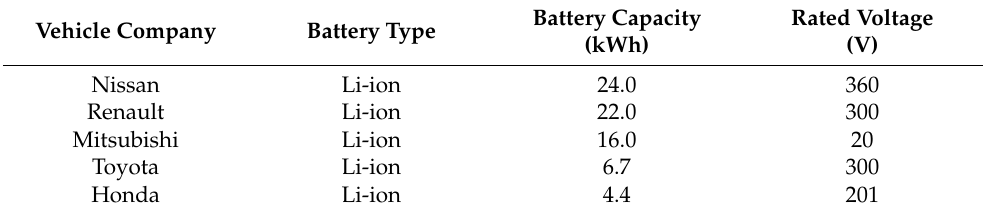
Table A4. Ratings of PHEV’s